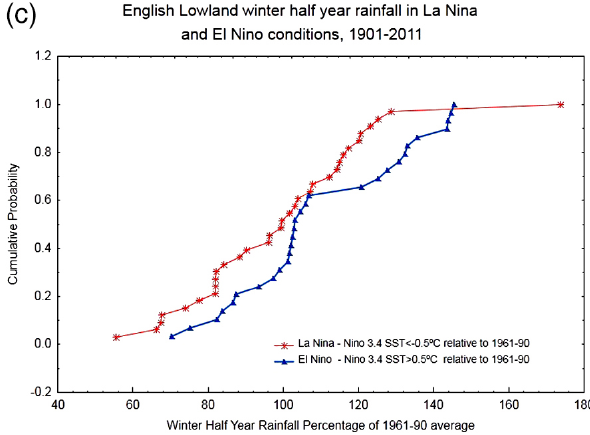
Figure 7. (a) Composite global SST anomalies from 1961 to 1990, winter half-year, over 1901–2013 when Niño3.4 anoma- lies < − 1.0 ◦ C. (b) Top panels: global PMSL anomalies (hPa) from the Twentieth Century reanalysis averaged over winter half-year for La Niñas measured by SST < − 1 standard deviation over Niño3.4, corresponding to a 1961–1990 SST anomaly < − 0.92 ◦ C, for two independent epochs 1876–1950 (left panels) and 1951–2009 (right panels). The standard deviation is for 1951–2010. Central panels (left panels): global storminess anomalies, 1951–2013, measured by anomalies of 2–7 day band pass variance of 500hPa height (dm 2 ), (right) western European rainfall anomalies (mmmonth − 1 ), 1901– 2011, for La Niñas for the winter half-year. Bottom panels (left panels): as top right panel for moderate El Niños (anomalies of 0.92 ◦ C < Niño3.4 < 1.5 ◦ C); (right panels) as central right panel but for moderate El Niños. Dark colours are locally significant at the 5% level. Light colours on global maps only (all diagrams) are included that show the patterns more clearly but are not significant. Rainfall from the Mitchell and Jones (2005) 0.5 ◦ × 0.5 ◦ data set, as it is for Figs. 9–12. (c) Cumulative distributions of English Low- lands rainfall, 1901–2014, expressed as a percentage of the 1961– 1990 average, for (i) La Niña and (ii) El Niño conditions excluding extreme El Niños, as described in the text.